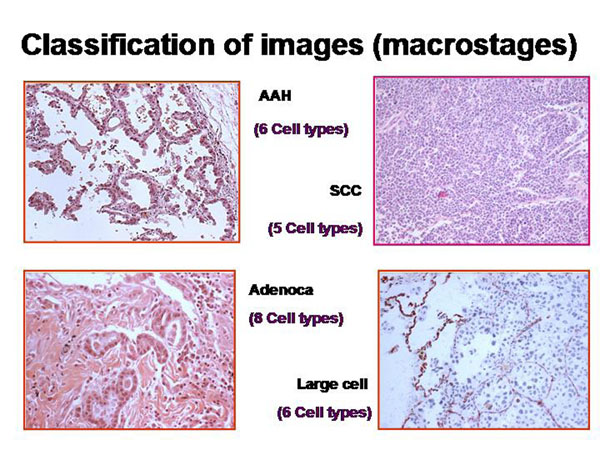
Example of cell types in histological images of lung diseases (atypical adenomatoid hyperplasia (AAH), small cell anaplystic carcinoma (SCC), Adenocarcinoma (Adenoca), and large cell anaplastic carcinoma (Large cell) used for entropy calculation (Shannon and Tsallis)